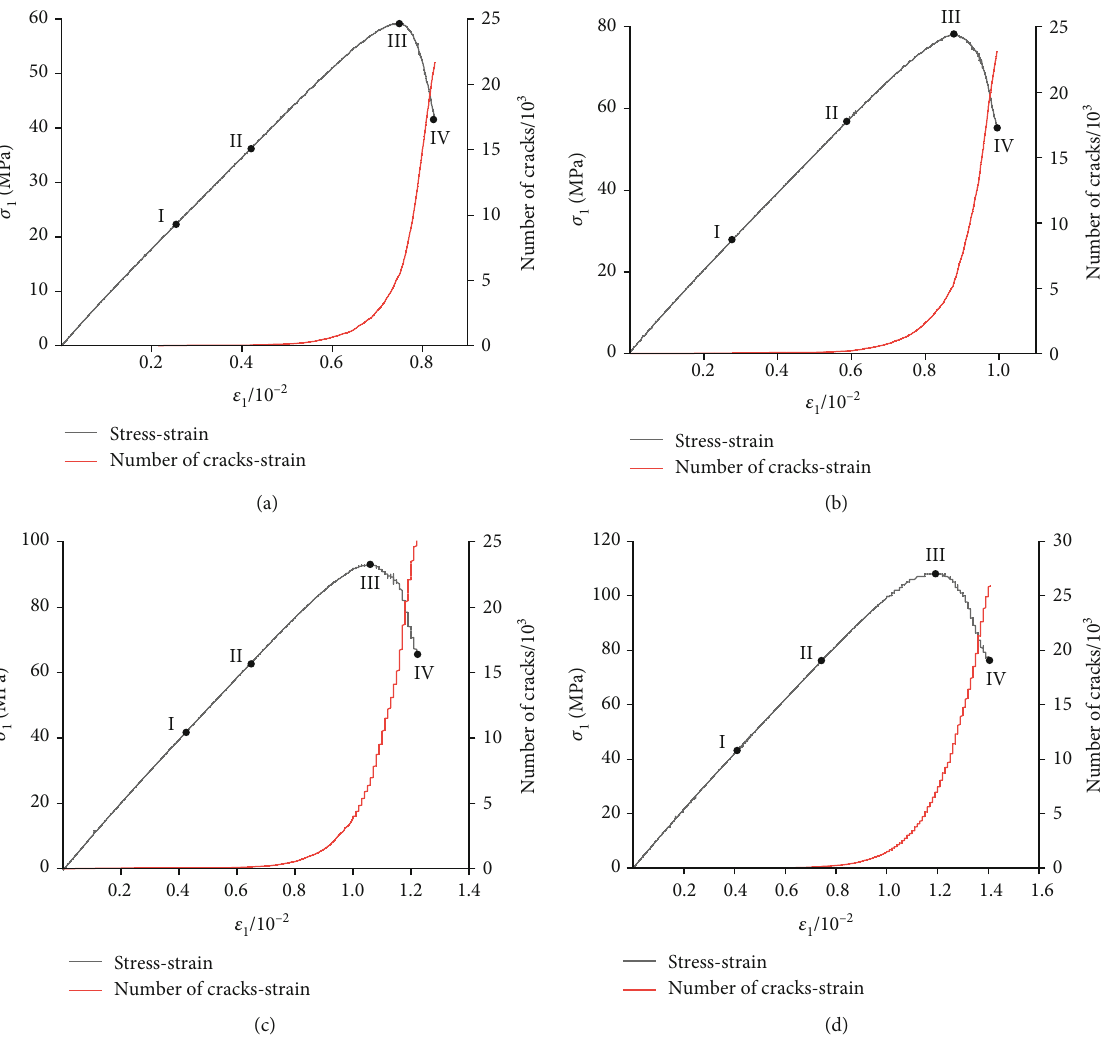
Figure 12: The number of microcracks in red sandstone under di ff erent con fi ning pressure conditions: (a) 5MPa; (b) 10MPa; (c) 15 MPa; (d)